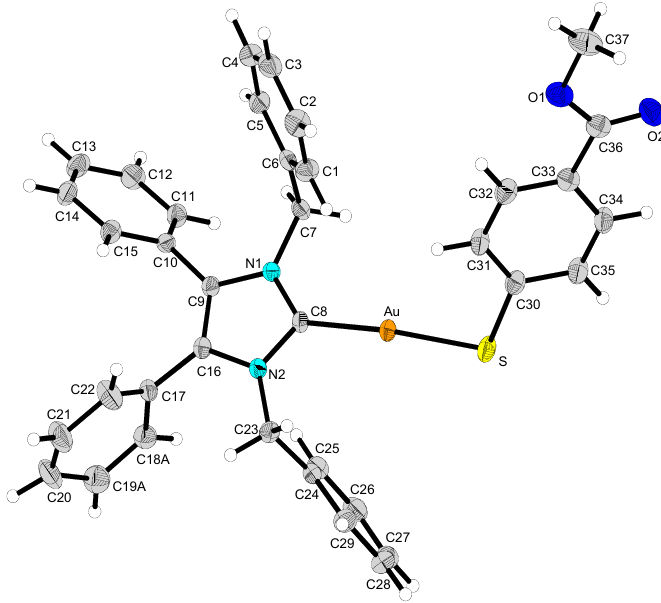
Figure 5 . X-ray diffraction structure of 13 ; thermal ellipsoids are drawn on the 50% level, disorder neglected.